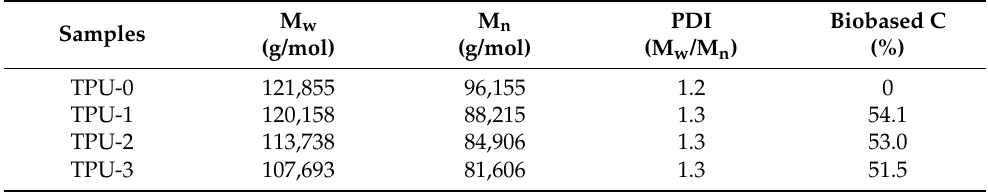
Table 2. Molecular weight and polydispersity of synthesized TPU samples.